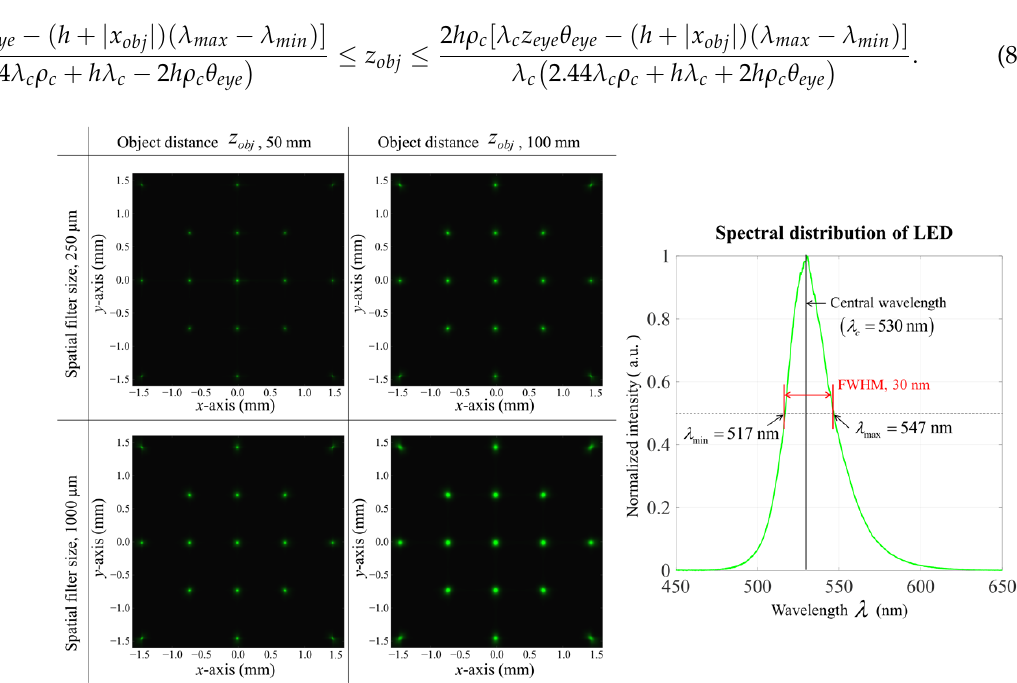
Figure 5. Numerical reconstruction of voxels with different positions on object plane and the spectral distribution of the LED light source.